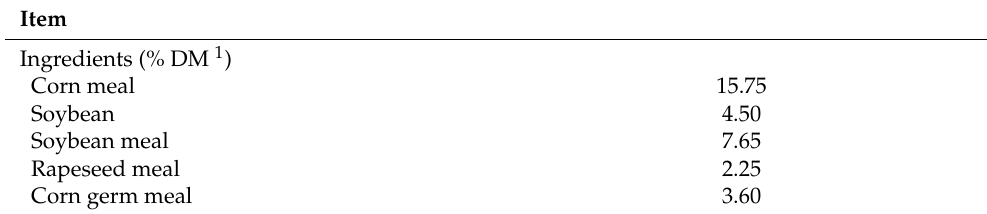
Table 1. Ingredients and chemical composition of basic